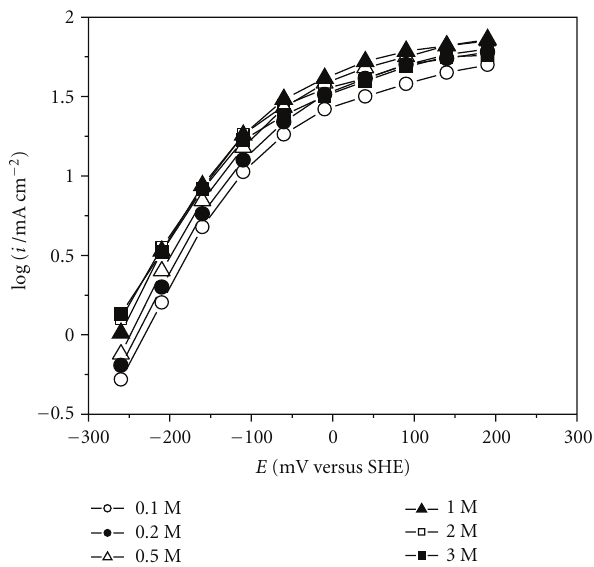
Figure 6: Potentiostatic polarization plots for methanol oxidation on Pt-Pd/C electrode in 0.5 MNaOH at various methanol concen- trations at 25 ◦ C.